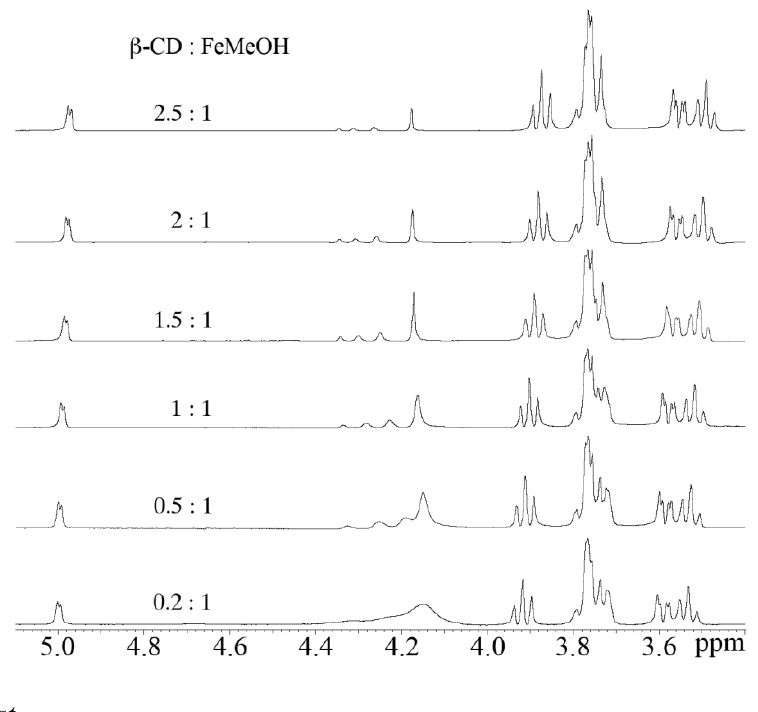
Figure 7. The 1 H NMR spectra of  -CD and FeMeOH in different molar